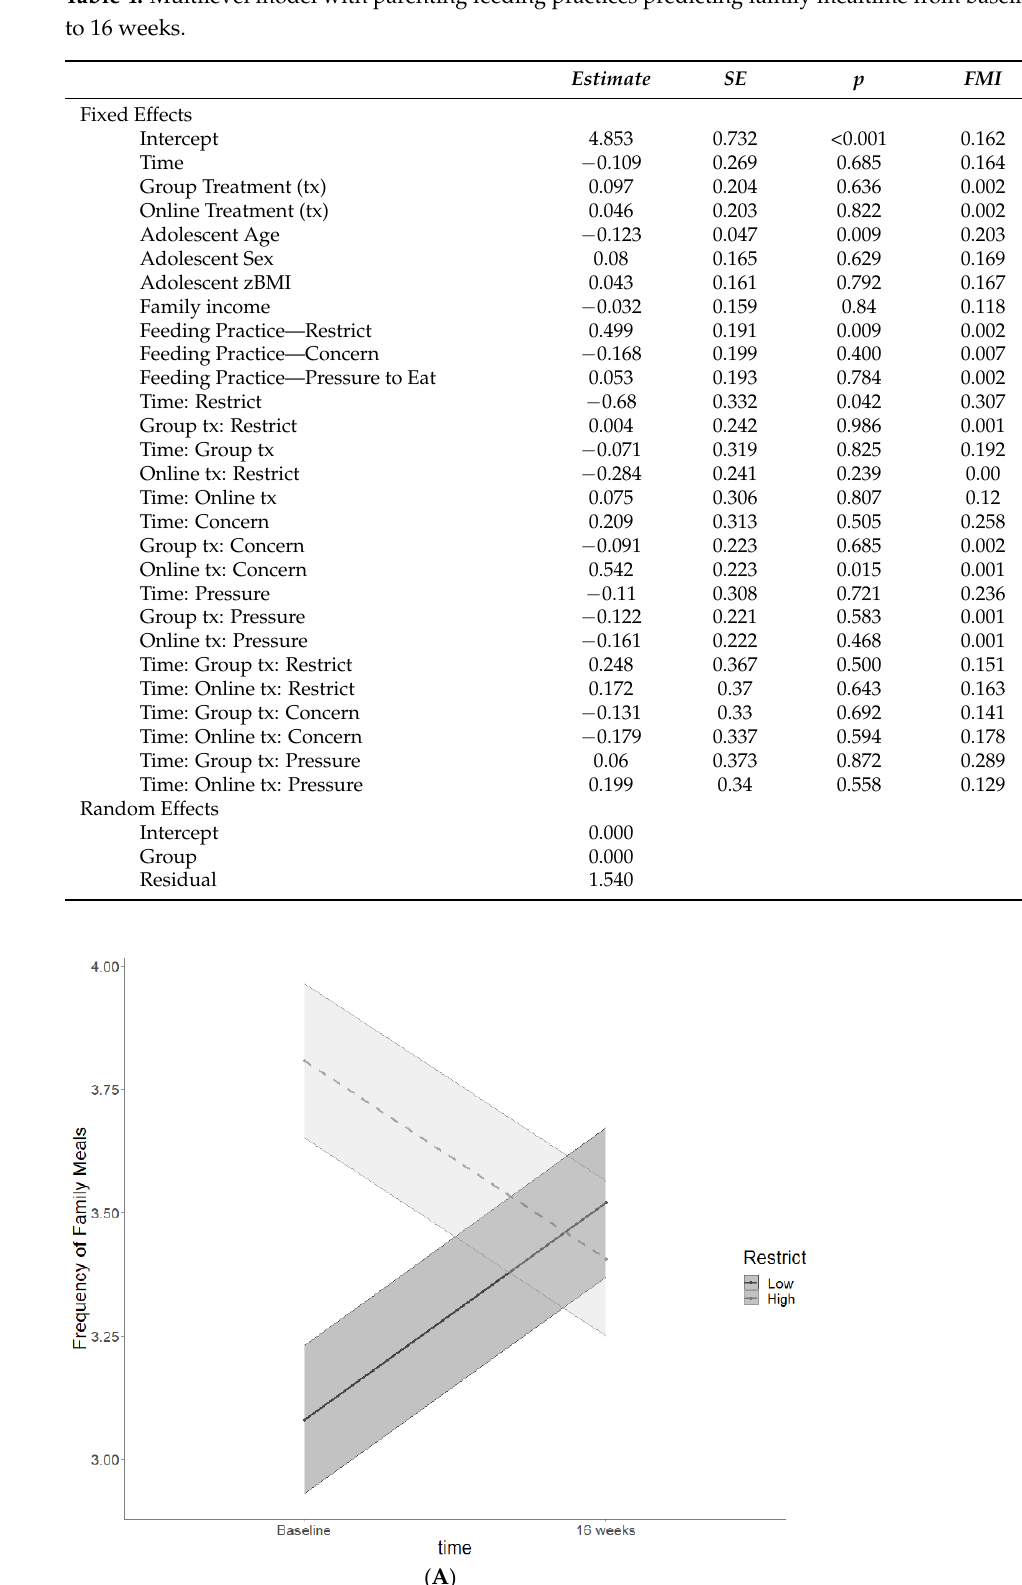
( B ) Figure 2. Two-way interactions with parenting feeding practices, including time x restriction ( A ) and online treatment x concern ( B ) predicting frequency of family meals. 4. Discussion The present study evaluated whether parenting style and parental feedback practices moderated the FIT treatment effects on frequency of family mealtime from baseline to 16 weeks. Both demandingness and responsiveness moderated the effect of the group treat- ment on family meals at 16 weeks. As hypothesized, for those in the group intervention condition, decreases in parental demandingness and increases in parental responsiveness